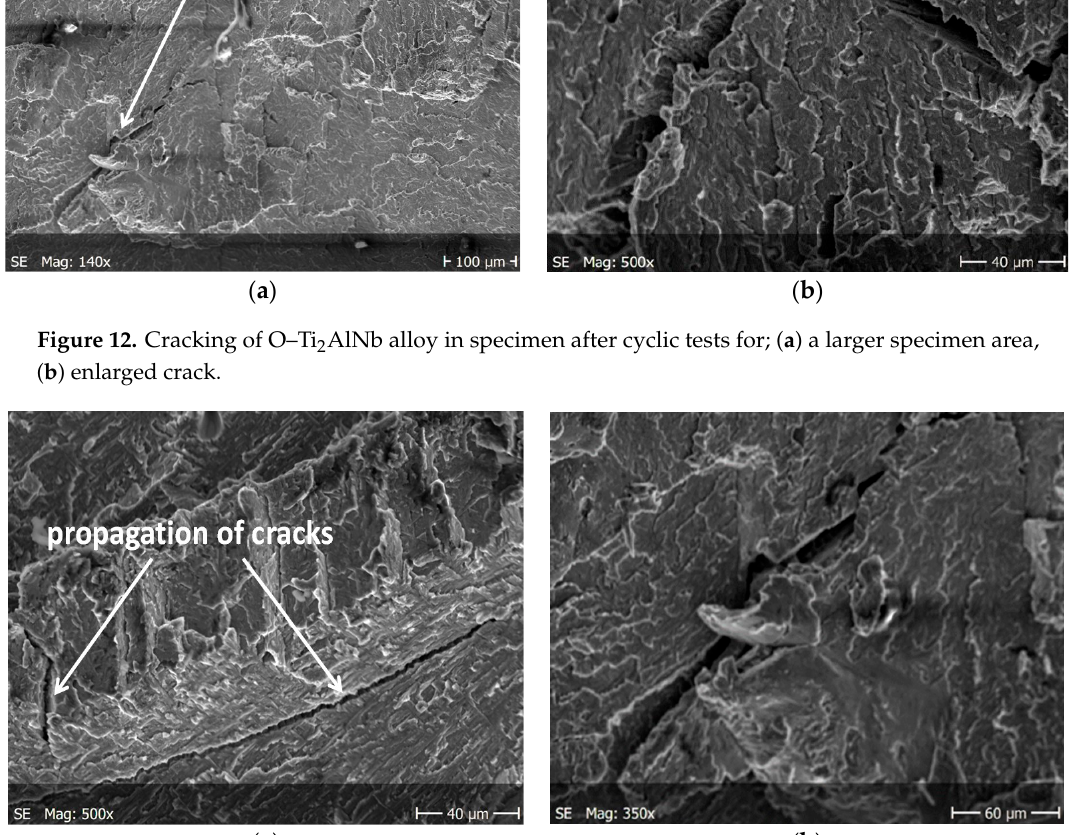
Figure 13. Cracking of O–Ti 2 AlNb alloy in specimen after cyclic tests for ( a ) a larger specimen area, ( b ) enlarged crack. ( b ) enlarged